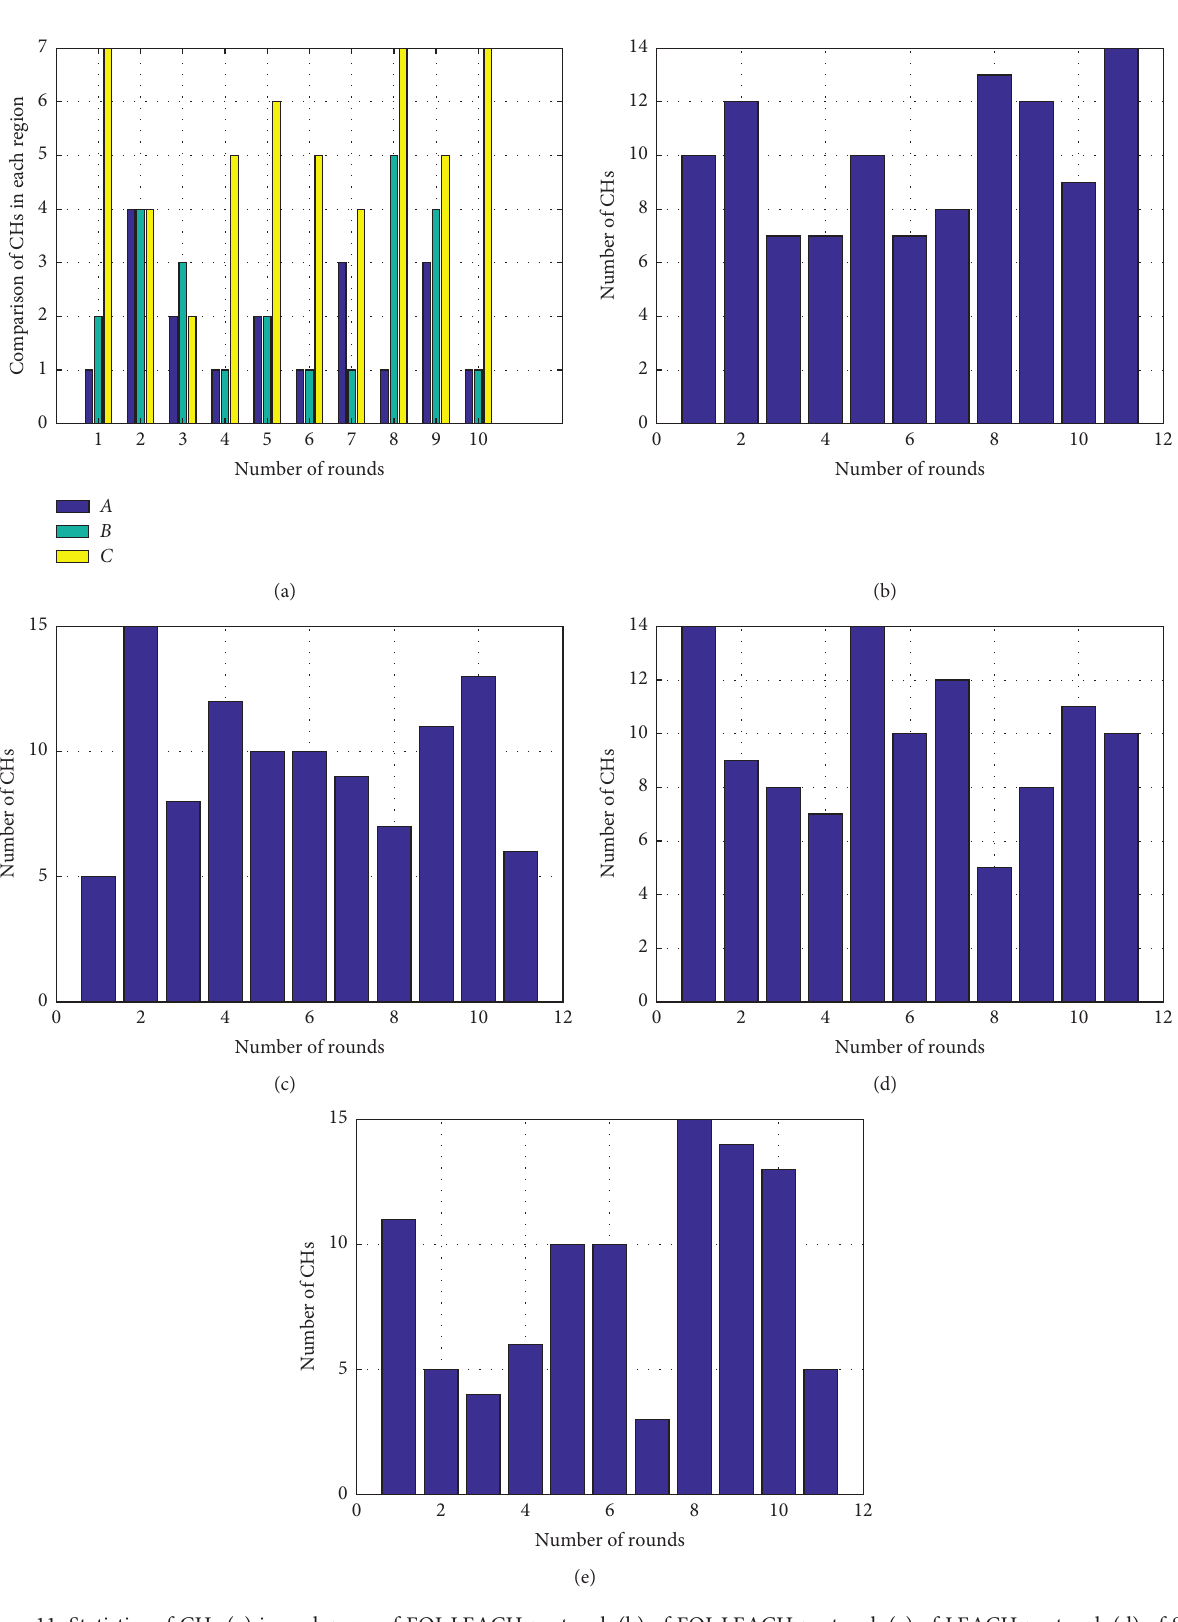
Figure 11: Statistics of CHs (a) in each zone of FOI-LEACH protocol, (b) of FOI-LEACH protocol, (c) of LEACH protocol, (d) of SEP protocol, and (e) of PECRP protocol without power